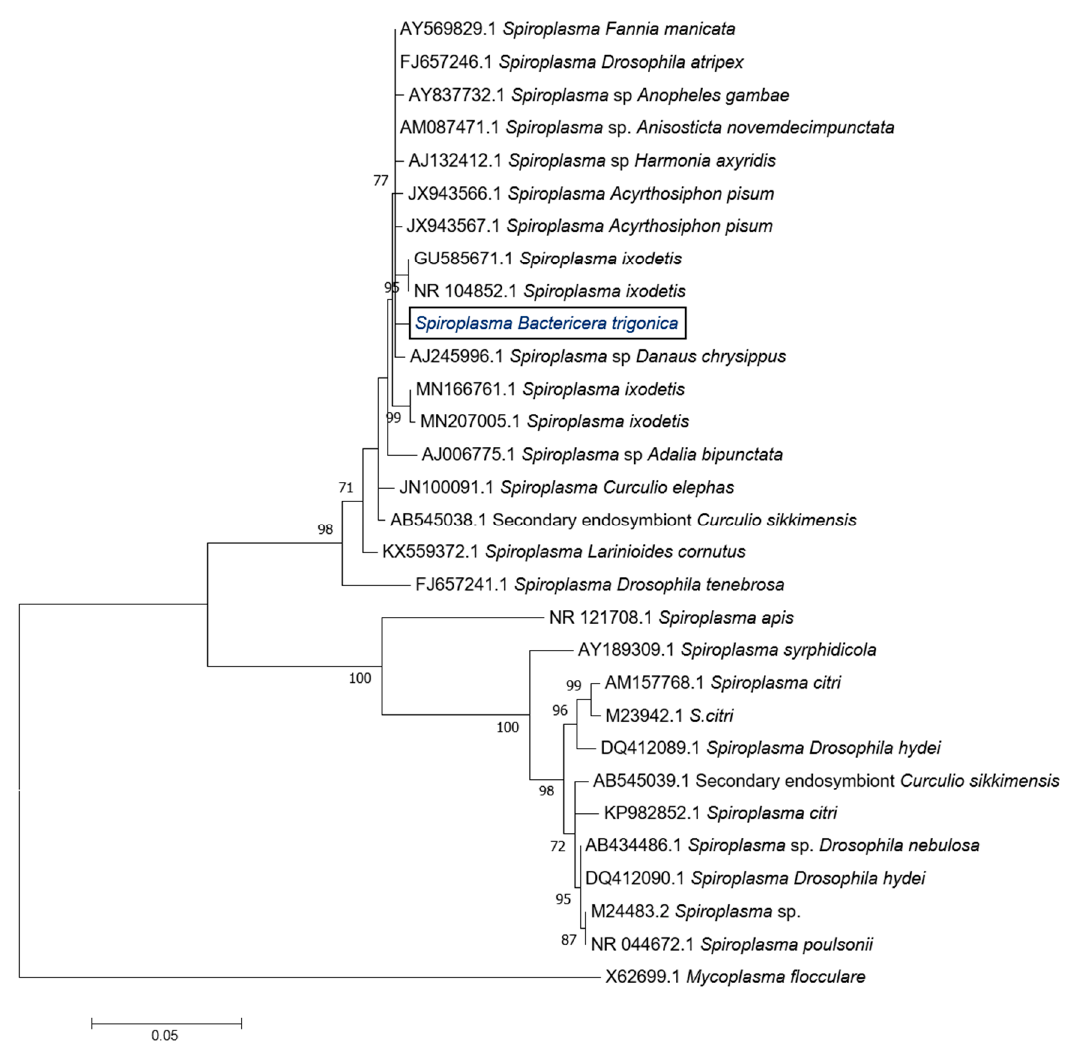
Figure 2. Maximum likelihood phylogenetic tree of 16S rDNA nucleotide sequences of Spiroplasma (1193 bp) by T93 + G nucleotide substitution model using MEGA 6.